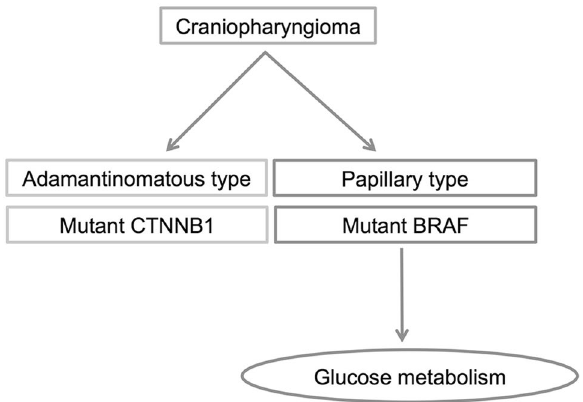
Figure 1. Relationship between clinicopathological subtypes in craniopharyngioma and enhancement of glucose metabolism, including immunohistochemical overexpression of GLUT-1, HK-II, and high uptake of [ 18